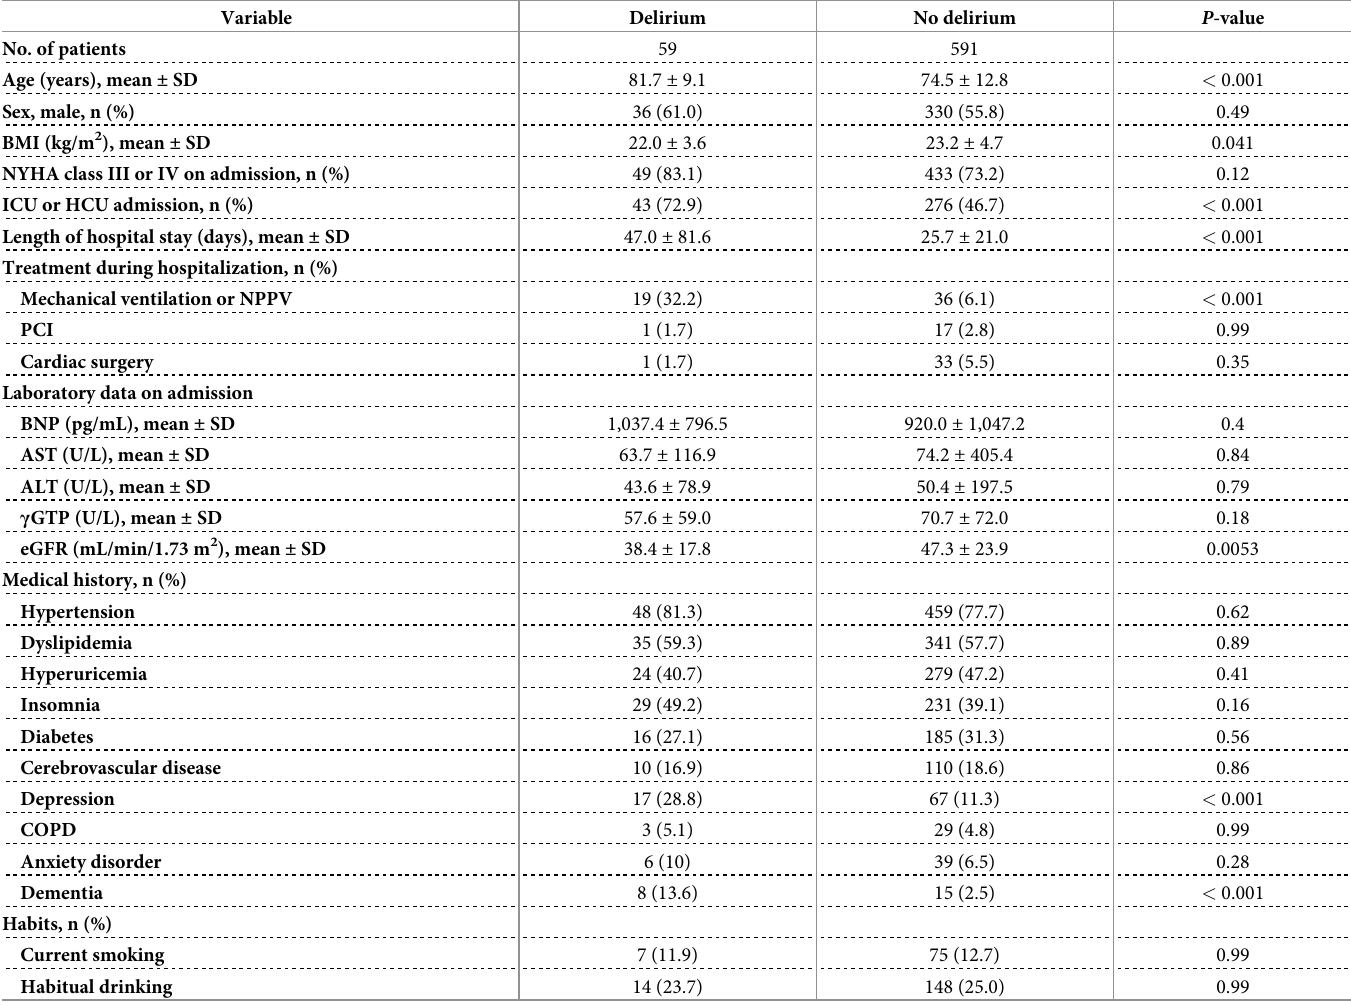
Table 1. Baseline characteristics of